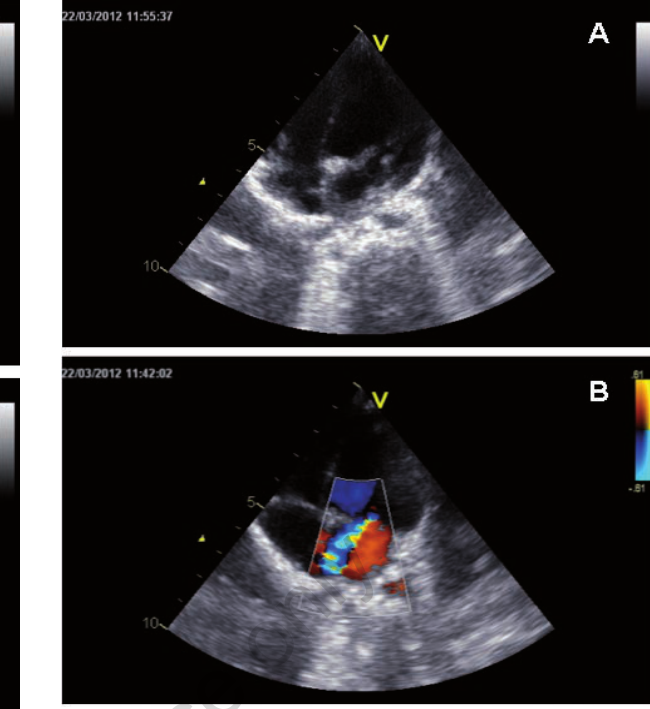
Figure 15. A) Farber syndrome. Mitral valve aspect in a 1-year old boy; B) Mitral valve